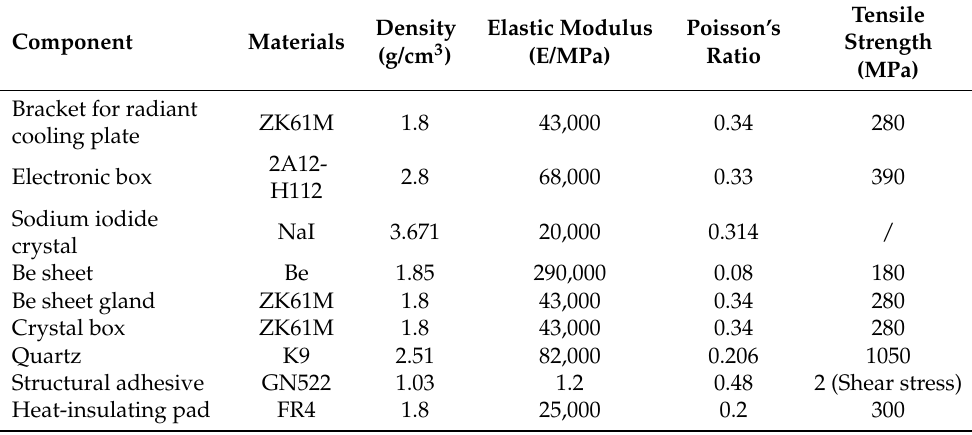
Table 2. Material parameters of each component for the novel GRM assembly.